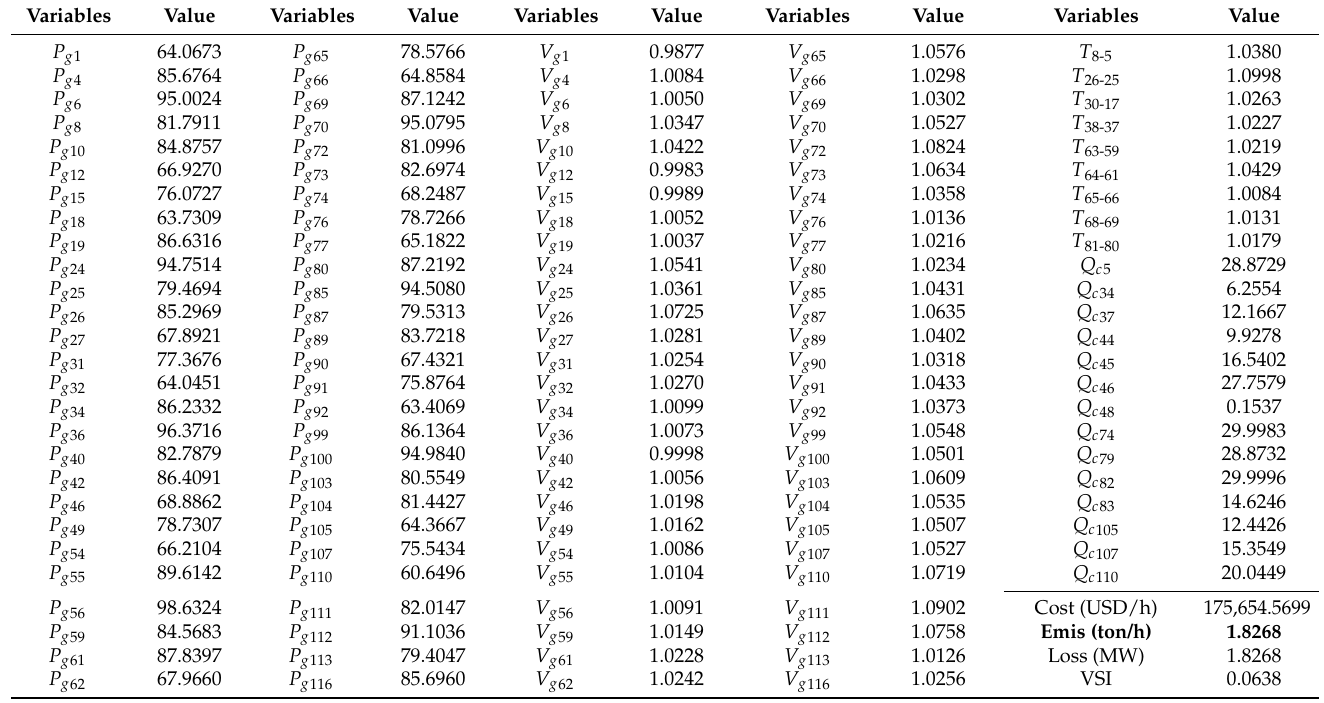
Table A3. Optimal solutions provided by MaMPA when considering emission as the objective function in the IEEE 118-bus system (case 6).